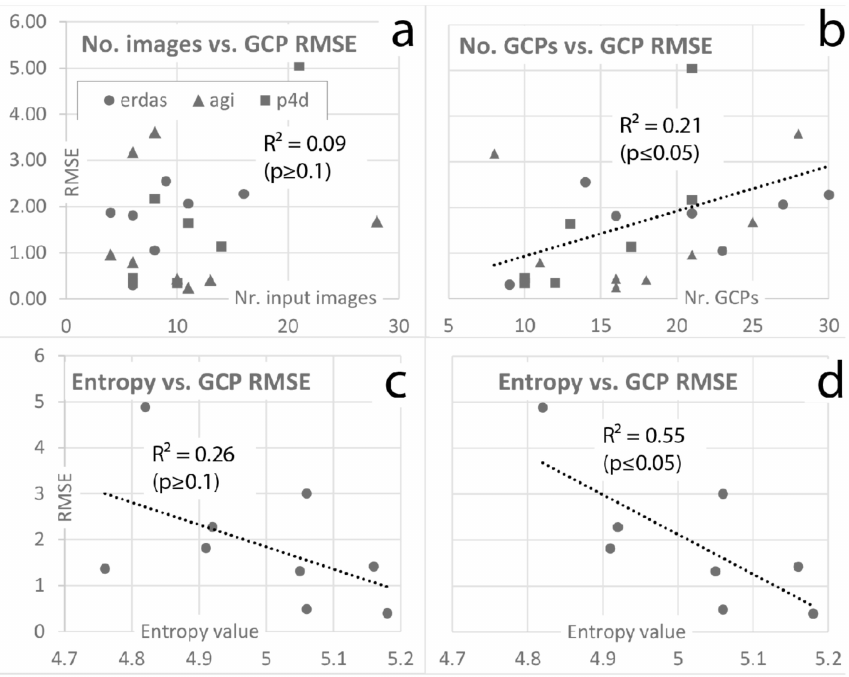
Figure 3. Parameters potentially influencing the DTM Root mean square error: the number of input images ( a ); the number of GCPs ( b ); and image texture/entropy ( c ); excluding one outlier ( d